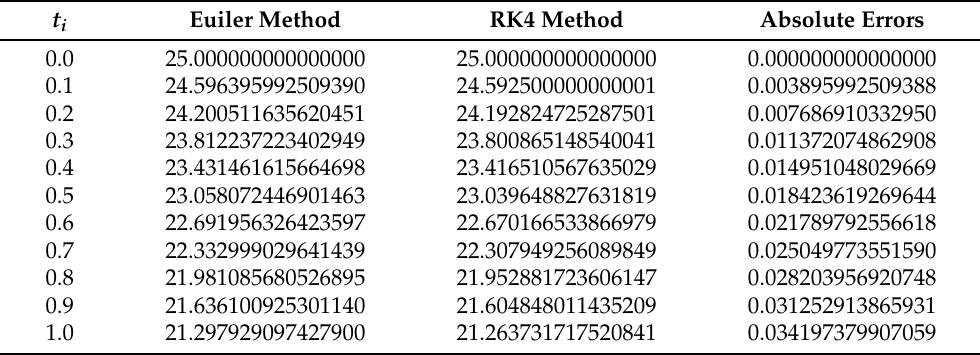
Table 3. Comparison between the results of the Euler method and RK4 method for V ( t ) .